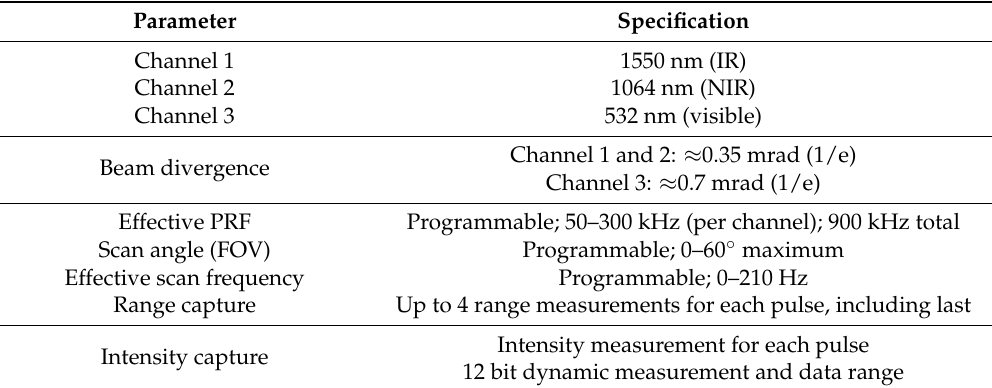
Table 2. Summary of the Optech Titan sensor